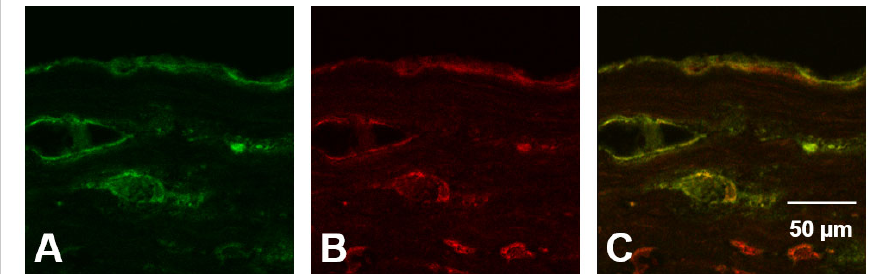
Figure 13. Immunofluorescence staining for aggrecan and HOCl-modified epitopes and colocalization in human atherosclerotic lesion material. Frozen sections (5 µ m thick) of an arteria femuralis from a 56-year-old female patient (lesion type II-III) were incubated with a mAb against aggrecan followed by an incubation with a Cy-2 (green fluorescence)-labelled goat anti-mouse IgG used as a secondary antibody (panels A , C ). HOCl-modified proteins were detected by using a Cy-3-labelled mAb (clone 2D10G9, red fluorescence, B , C ). Merged images ( C ; yellow fluorescence) show the re ‐ sulting overlay of aggrecan and HOCl ‐ modified epitopes, with a significant co ‐ localization detected in the basement membrane underlying the endothelial cell layer (top part of image C ) and around vasa vasorum. Cells (most likely macrophages as deduced from morphology) located in the lower part of the image do not react with the anti ‐ aggrecan mAb but show a strong signal for HOCl ‐ mod ‐ ified proteins. Oil red staining revealed disperse cholesterol deposits in the intima and media of the sclerotic arteries and macrophages (data not shown). Scale bar: 50 μ m.